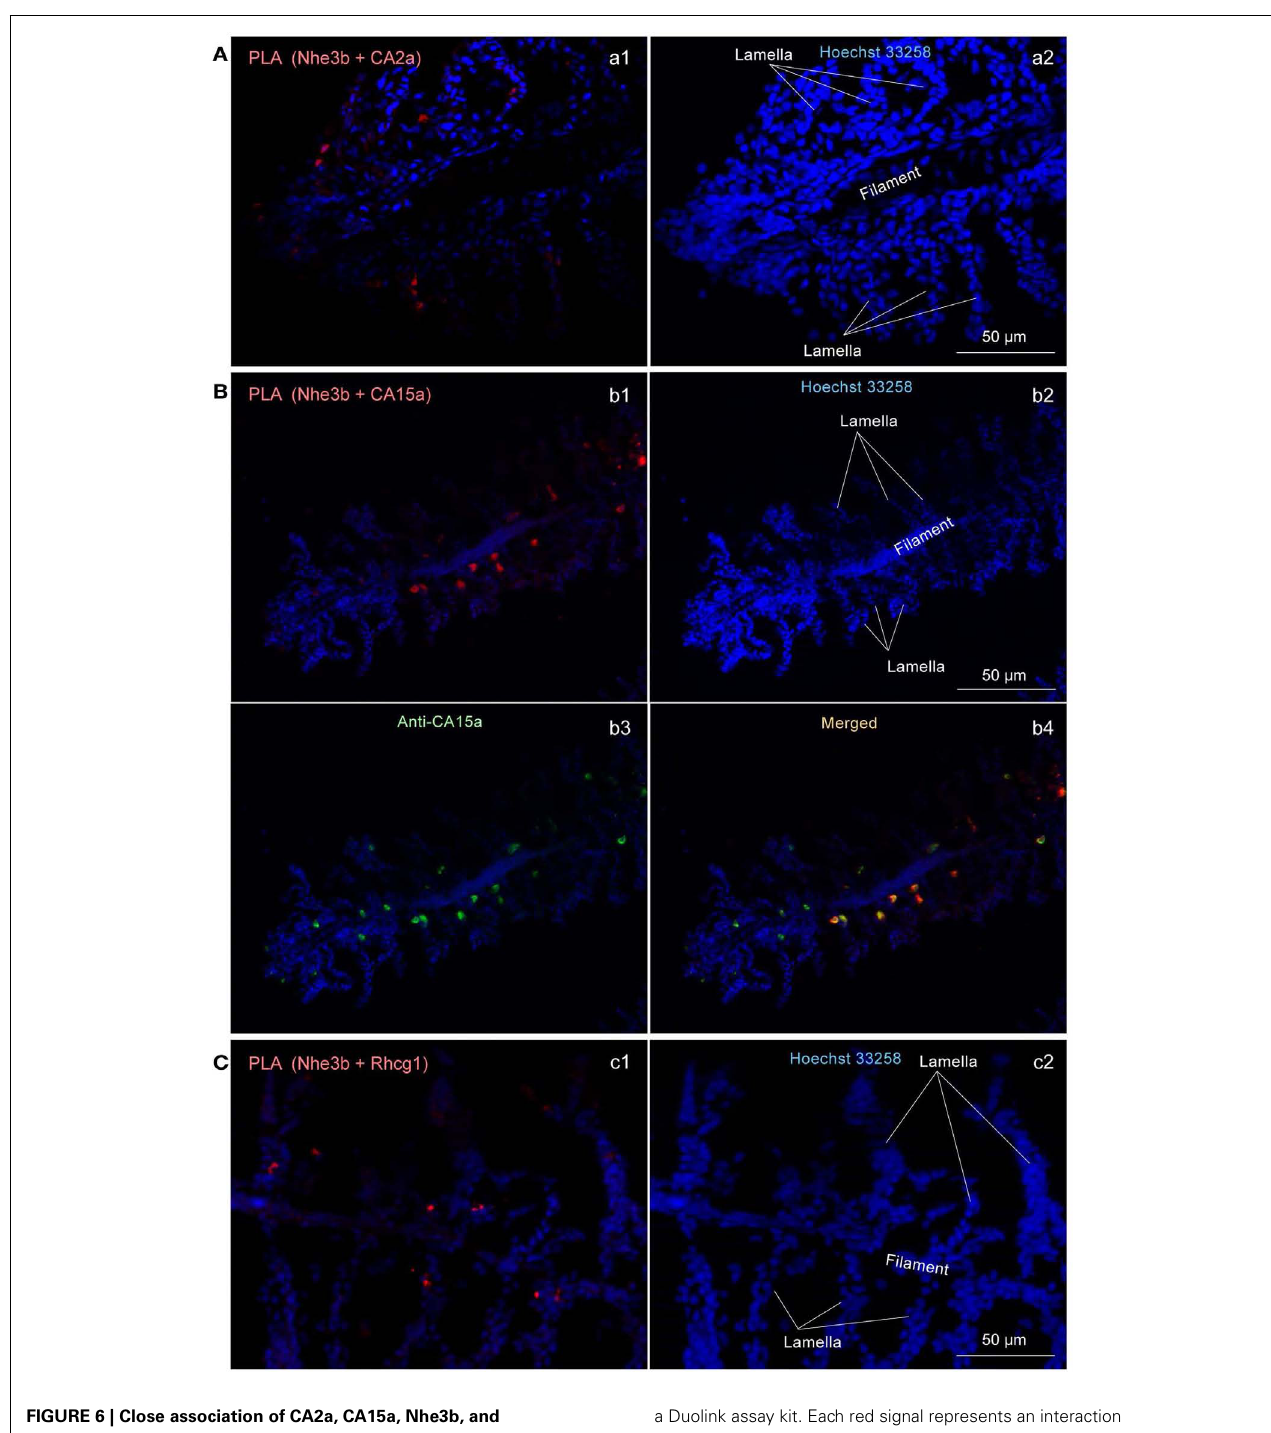
FIGURE 6 | Close association of CA2a, CA15a, Nhe3b, and Rhcg1 visualized by in situ proximity ligation immunoassay (PLA). (A–C) Zebrafish gills were fixed with 4% PFA, incubated with two primary antibodies (a1: rabbit anti-CA2a and rat anti-Nhe3b; b1: rabbit anti-CA15a and rat anti-Nhe3b; and c1: rabbit anti-Rhcg1 and rat anti-Nhe3b), and processed for detecting protein-protein interaction in situ with